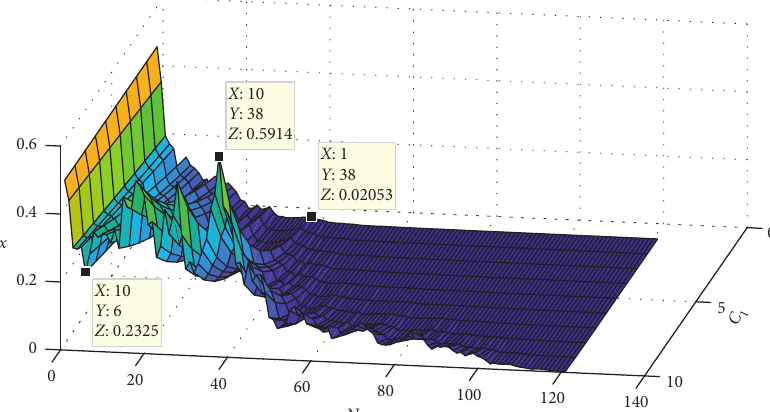
Figure 6: The impact of enterprise substantive innovation cost ( C